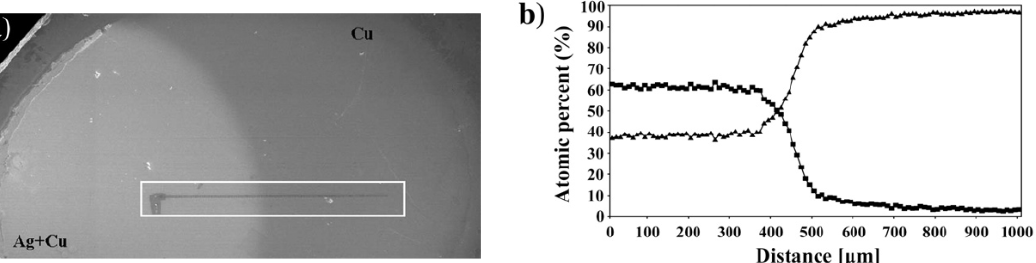
Figure 2. Optical micrograph of surface topography with indentations across the composition gra ‐ dient in a Cu–Ag nanocomposite ( a ). The variation of the composition is shown in ( b ): ▪ Ag concen ‐ tration; ▴ Cu concentration. Reproduced with permission from [21]. Copyright © 2007, Elsevier. (cid:78) Cu concentration. Reproduced with permission from [21]. Copyright © 2007,